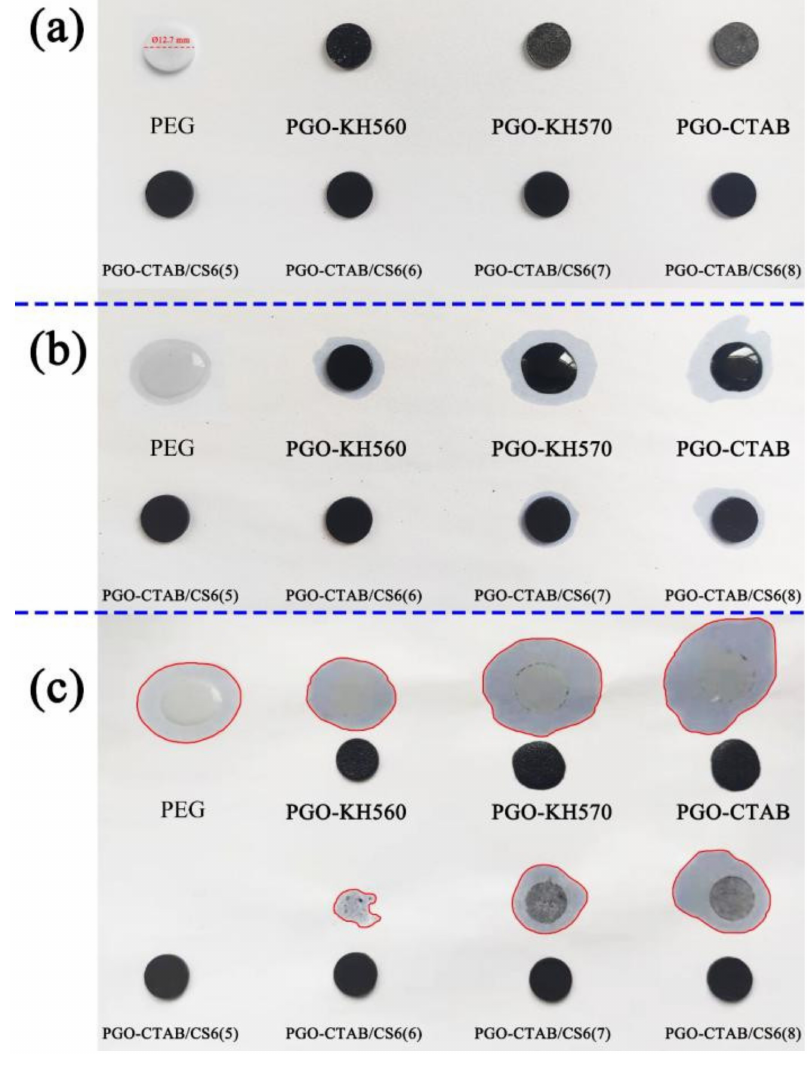
Figure 9. Leakage stability diagram of various PCMs at ( a ) 0 min, ( b ) 60 min, and ( c ) 180 min. Table 5. Leakage stability parameters of pure PEG6000 and various composite